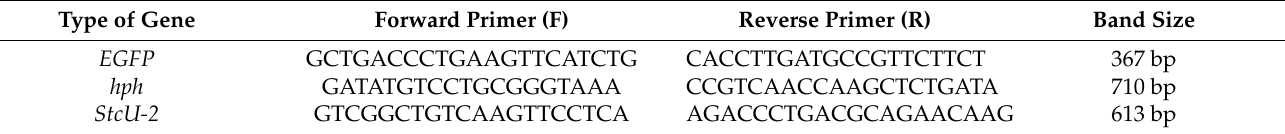
Table 1. List of primers to amplify targeted